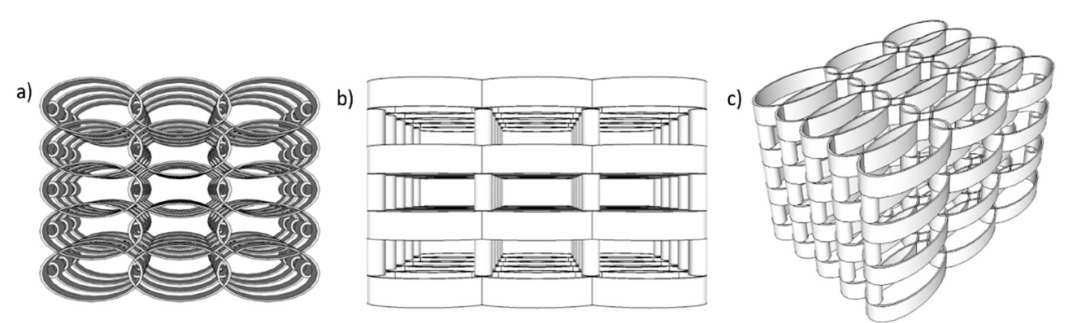
Figure 1. Line plot example of the optimized sca ff old design with five layers: ( a ) top view; ( b ) lateral view; ( c ) inclined